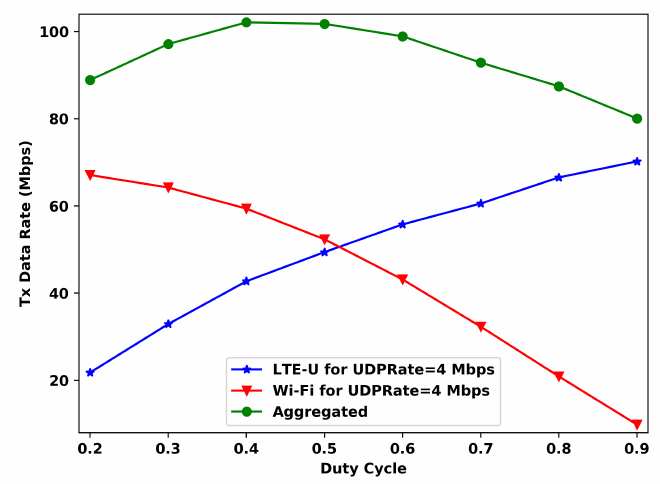
Figure 5. Data rate vs DC for 4 Mbps of offered data rate per